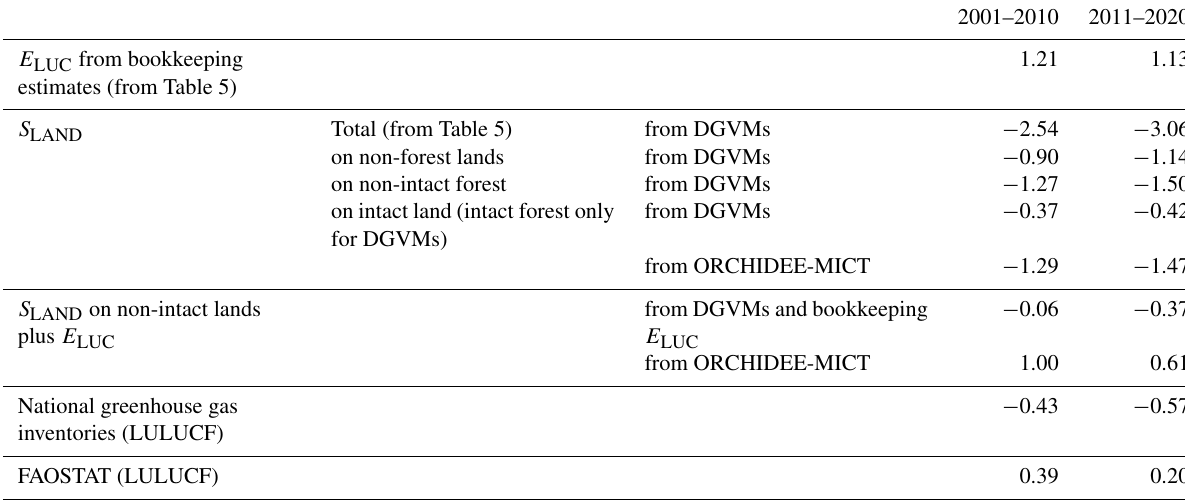
Table A8. Mapping of global carbon cycle models’ land flux definitions to the definition of the LULUCF net flux used in national reporting to UNFCCC. Non-intact lands are used here as proxy for “managed lands” in the country